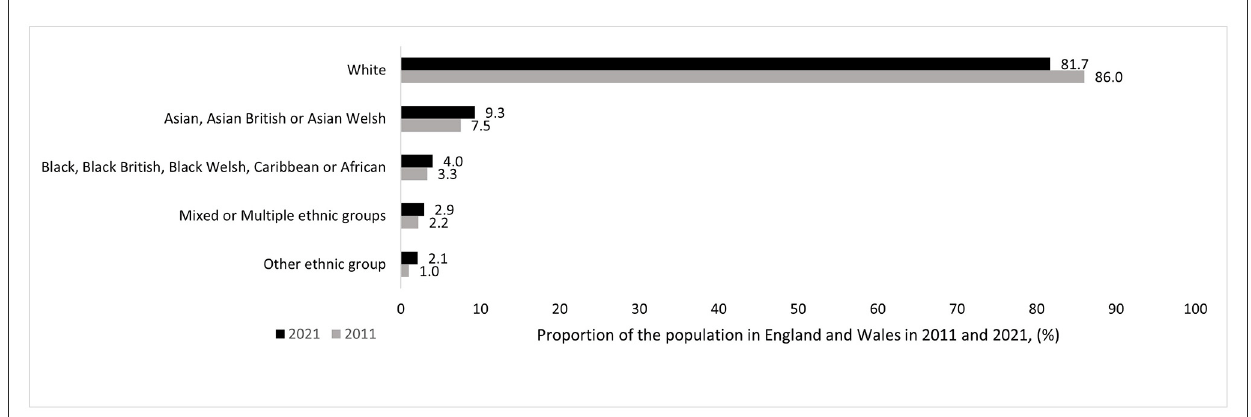
FIGURE1 Change in ethnic make-up of usual residents in England and Wales between 2011 and 2021